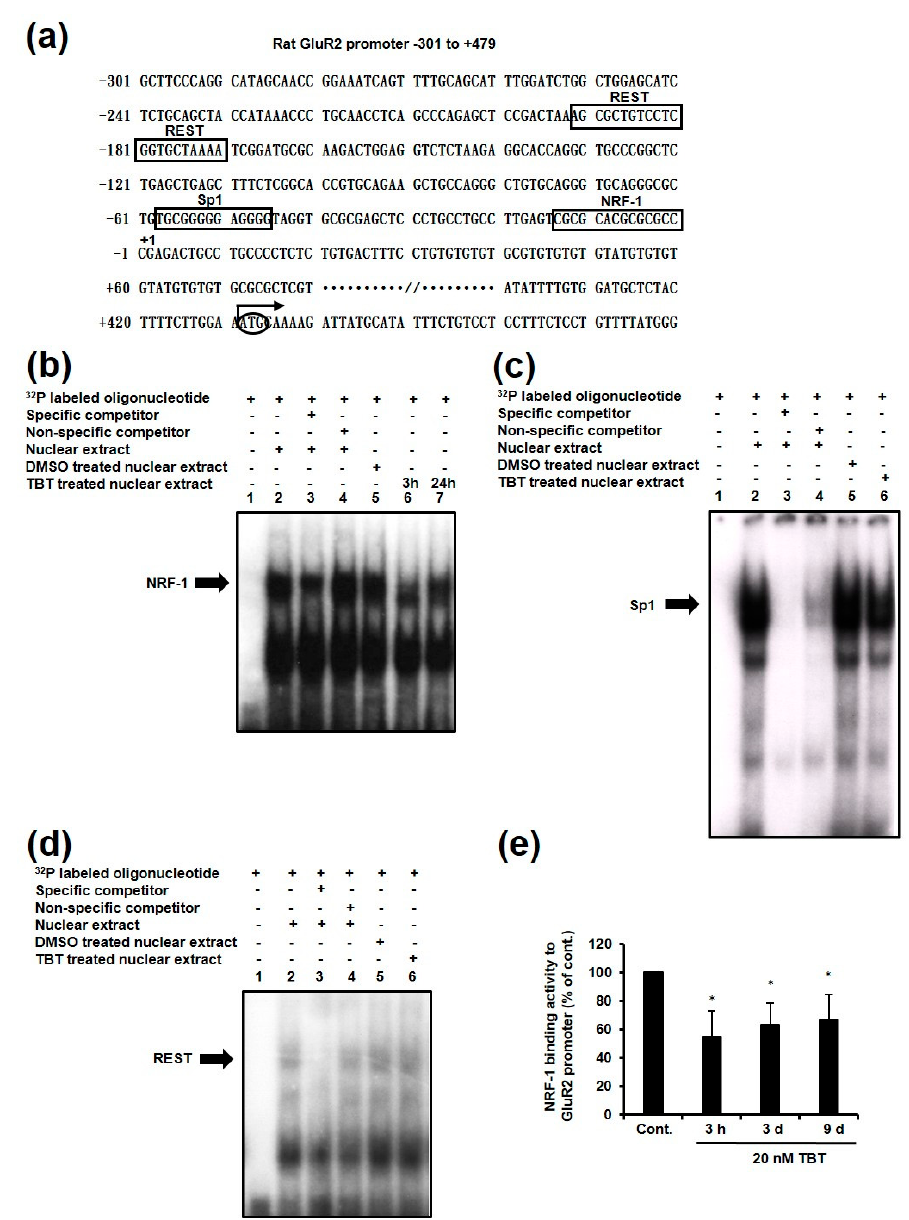
Figure 2. Effect of TBT on the binding activity of NRF-1, Sp1, and REST to their putative binding sites. ( a ) Partial nucleotide sequences of the rat GluR2 region, and the binding sites of NRF-1, Sp1, and REST. The 5 ′ -most prominent initiation site is shown as the +1 transcription initiation site, located 430 bases 5 ′ of the GluR2 AUG (bent arrow). Nuclear proteins were extracted from DMSO- or TBT-exposed cortical neurons, and the DNA binding activities of NRF-1 ( b ), Sp1 ( c ), and REST ( d ) were analyzed by EMSA. An excess of specific (lane 3) or non-specific (lane 4) oligonucleotides was added as a competitor. DMSO-treated nuclear extracts (lane 5) and TBT-treated nuclear extracts (lane 6 and 7) were incubated with 32P-labelled oligonucleotides containing the GluR2 promoter region, and DNA–protein complexes were separated from free DNA probes by gel electrophoresis. The arrows show specific band shifts; ( e ) Cortical neurons were exposed to DMSO as a control or 20 nM TBT for various times, and then the NRF-1 binding activity to the GluR2 promoter was examined by ChIP assay using NRF-1 antibody. Purified DNA samples were subjected to quantitative real-time PCR analyses, and the DNA levels were corrected relative to the input sample. The data are expressed as the mean + S.E.M. ( n = 5). * p < 0.05 vs. control.